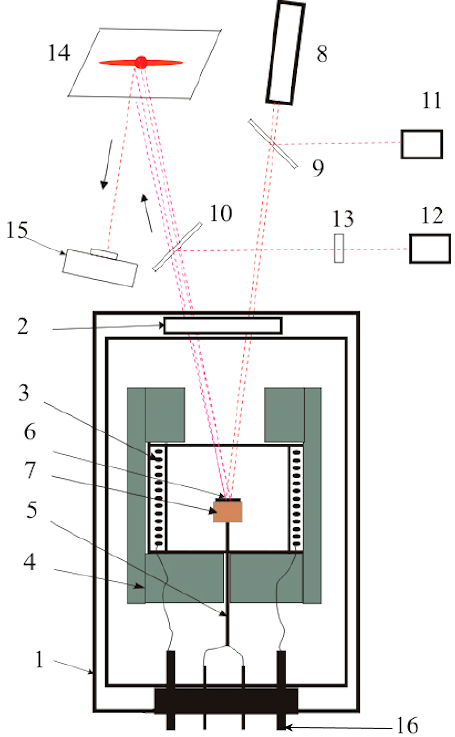
Figure 1. The schematic of the laboratory set-up: 1—vacuum chamber, 2—optical window, 3—electric heater, 4—thermal insulation, 5—thermocouple, 6—copper sample, 7—nickel substrate, 8—probe laser, 9 and 10—semi-transparent mirrors, 11 and 12—sensors, 13—interference filter, 14—flat screen, 15—digital camcorder, and 16—electrical connector. Adopted from Reference [1].